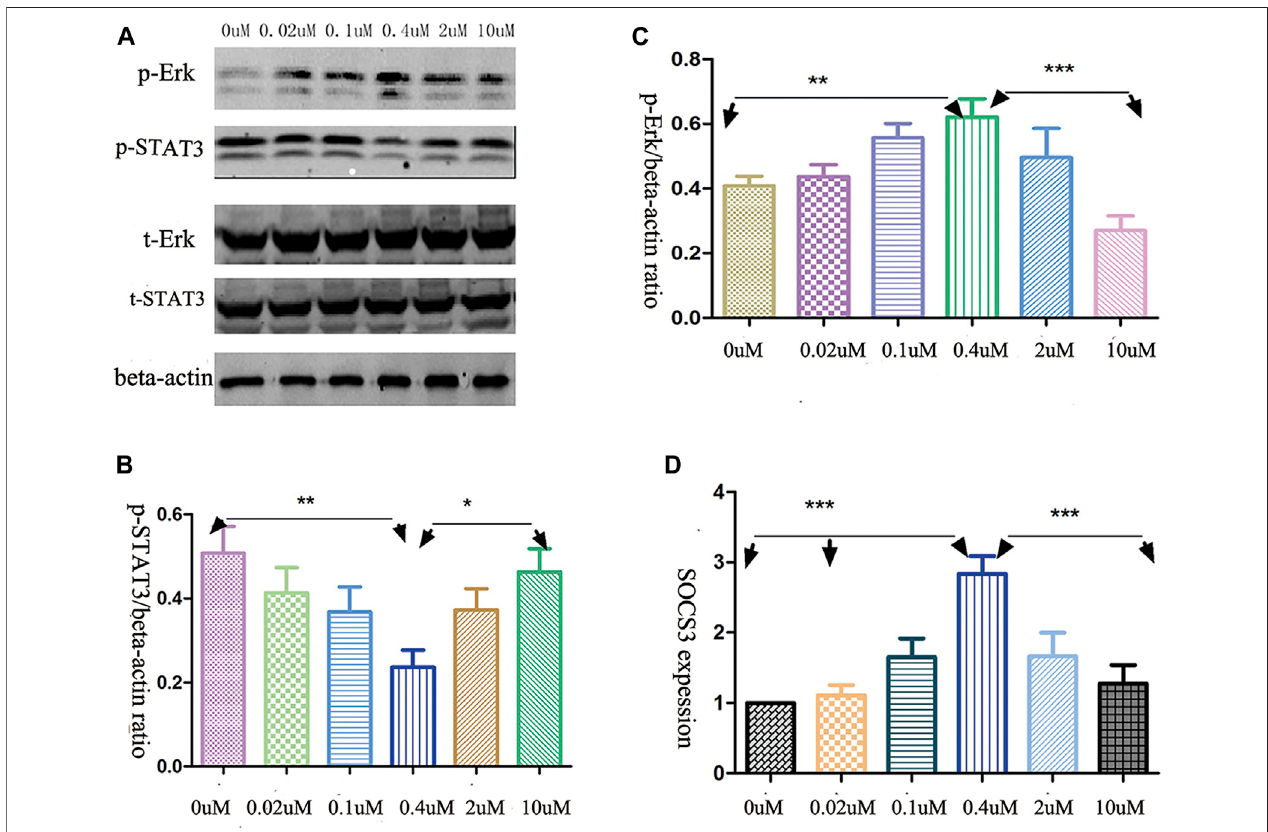
FIGURE4| Decitabineeffectsonsignalingpathways. (A) Westernblotanalysisrevealedtheoppositeeffectsofdecitabineexposureonp-ERKandp-STAT3levels (B,C) Quantitative analyses of relative p-STAT3 and p-ERK levels in NK cells, devired from seven patients, normalized to β -actin ( n (cid:2) 7, * p (cid:2) 0.03, ** p (cid:2) 0.0011, *** p < 0.0001). (D) qRT-PCR analysis of transcript levels of SOCS3, an endogeneous feedback inhibitor of STAT3 signaling pathway ( n (cid:2) 6, p <